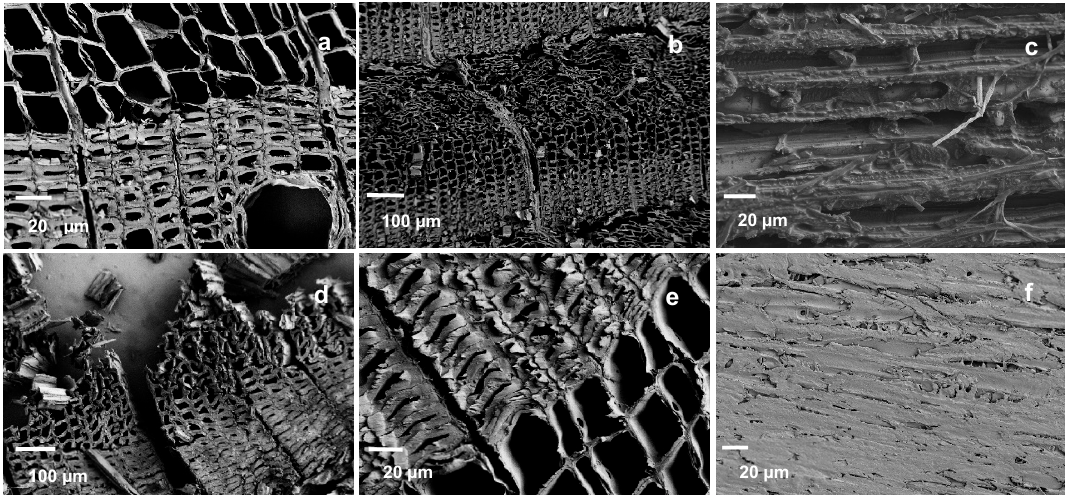
Figure 2. SEM images of ( a ) unmodified spruce, ( b ) compressed transverse pyrolysis zone of 300-30, ( c ) uncompressed tangential charred surface of 300-30, ( d ) compressed transverse charred surface of 400-3, ( e ) uncompressed pyrolysis zone of 400-3, ( f ) compressed tangential charred surface of 400-3.